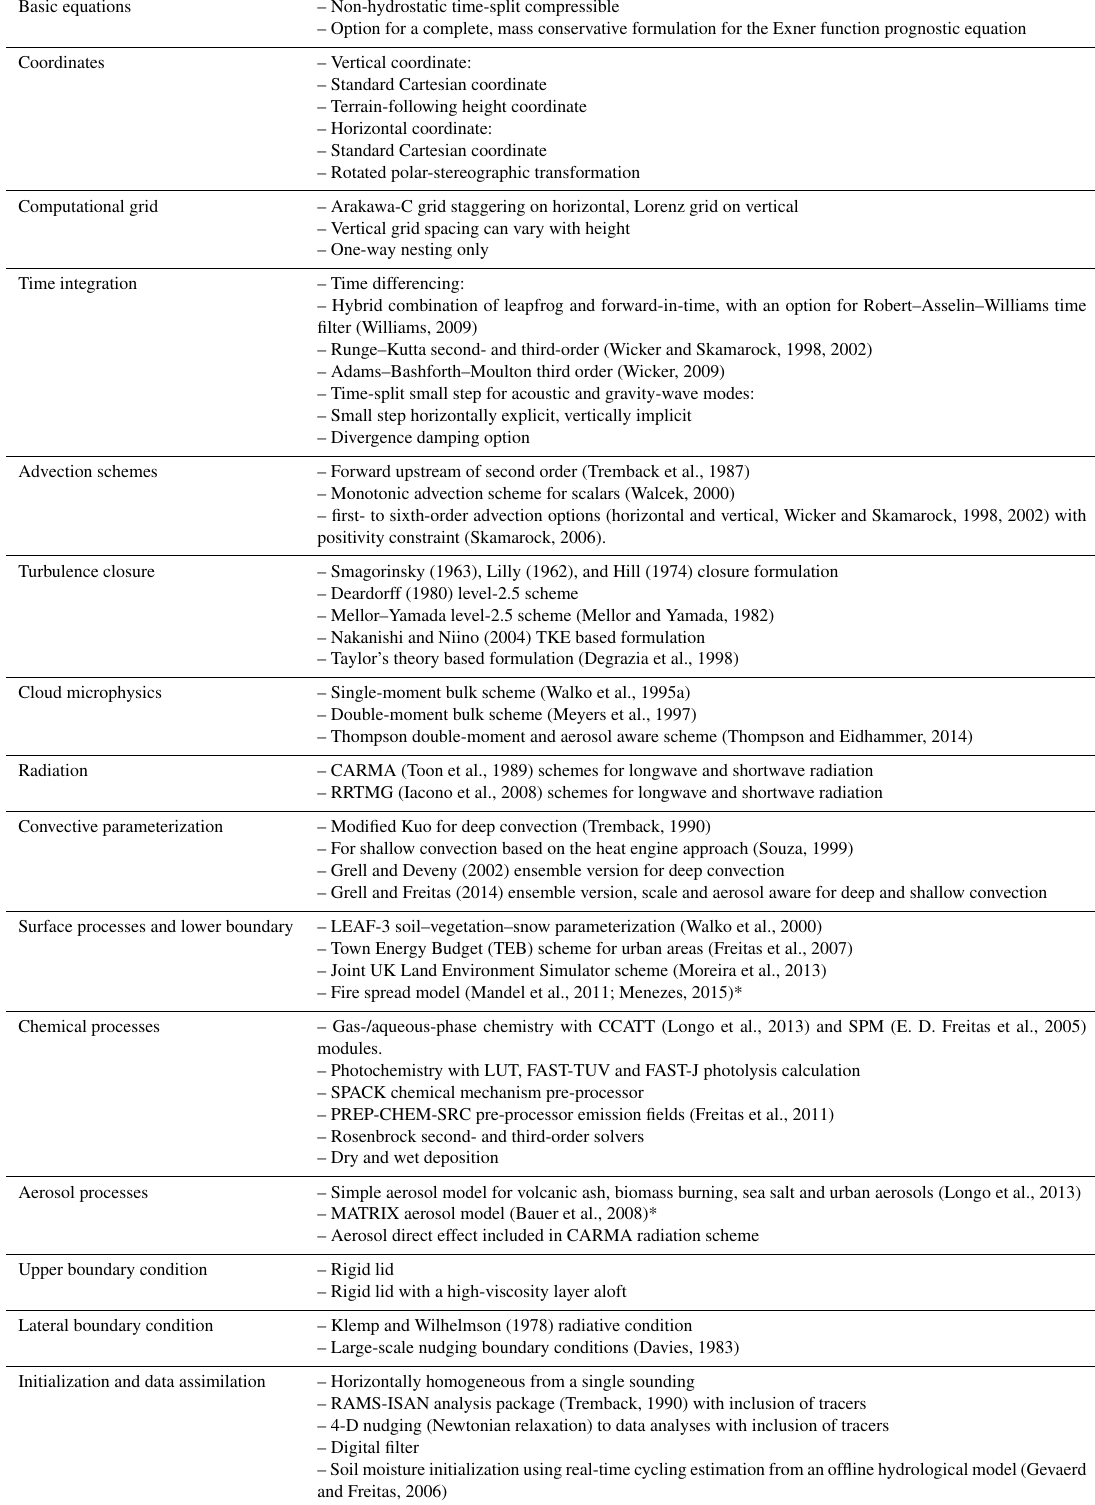
Table 2. Main configuration options in BRAMS